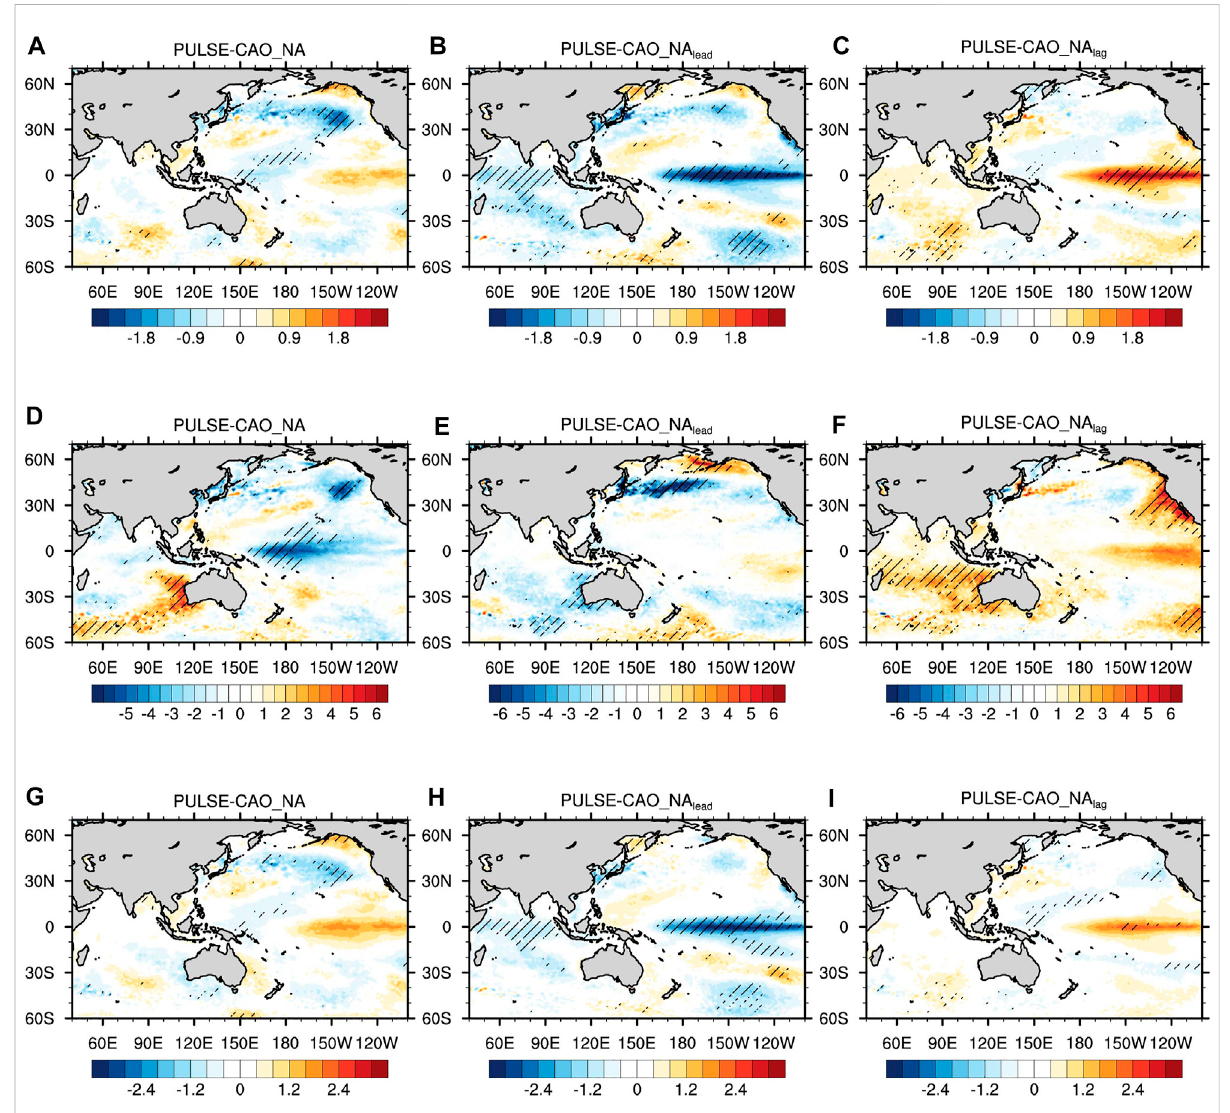
FIGURE 9 Regression maps of NDJFM mean SST anomalies during 1979 – 2015 against (A) the PULSE – CAO_NA index, (B) the PULSE – CAO_NA lead index, and (C) the PULSE-CAO_NA lag index. (D – F) and (G – I) are the same as (A – C) but for regressions against the interdecadal and interannual componentsofcouplingindices,respectively.Slashedareasdenotetheregressionsabovethe95%con fi dencelevelusingtwo-sidedStudent ’ s t